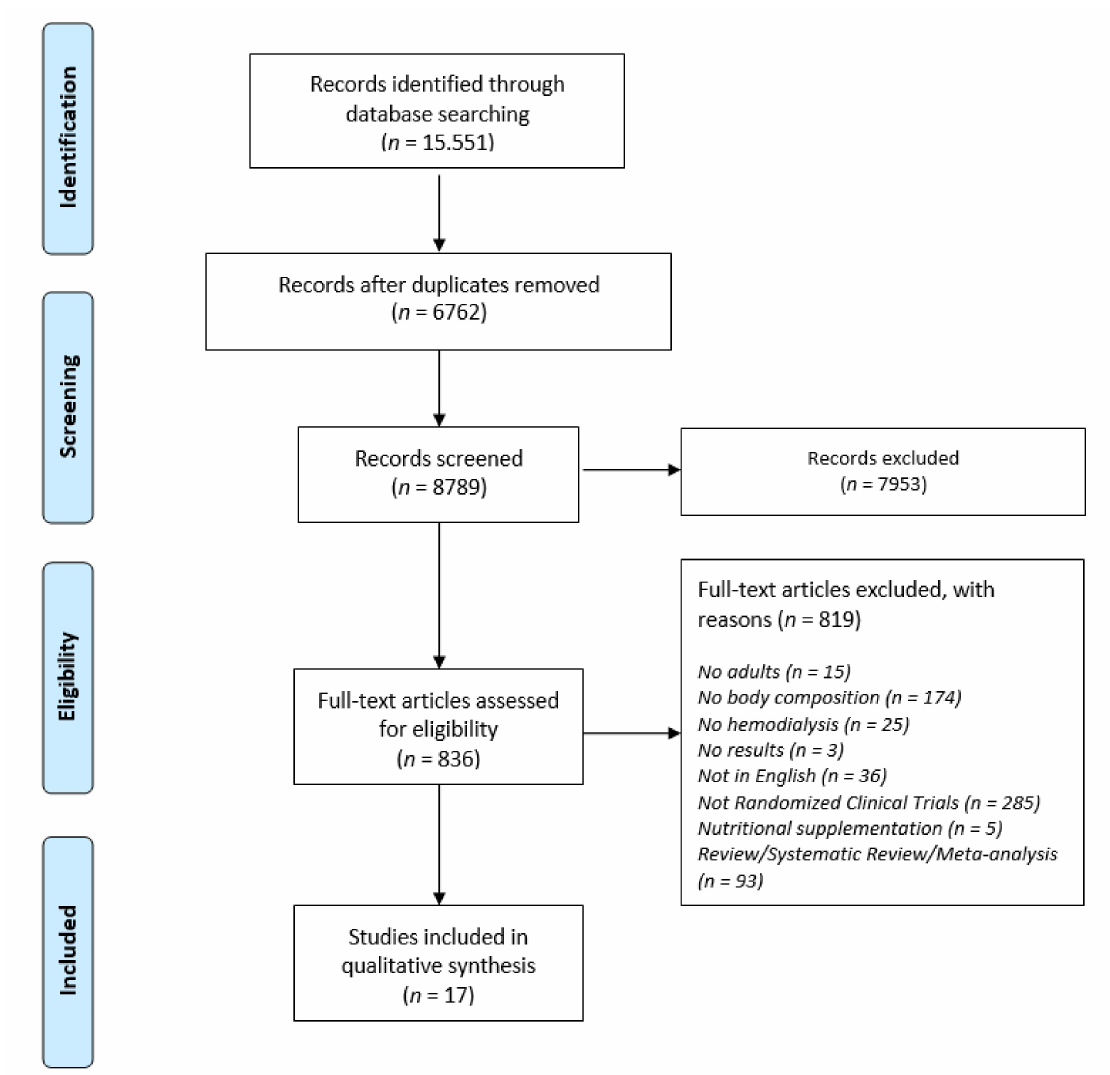
Figure 1. Preferred Reporting Items for Systematic Reviews and Meta-Analyses (PRISMA) flow diagram of the study selection